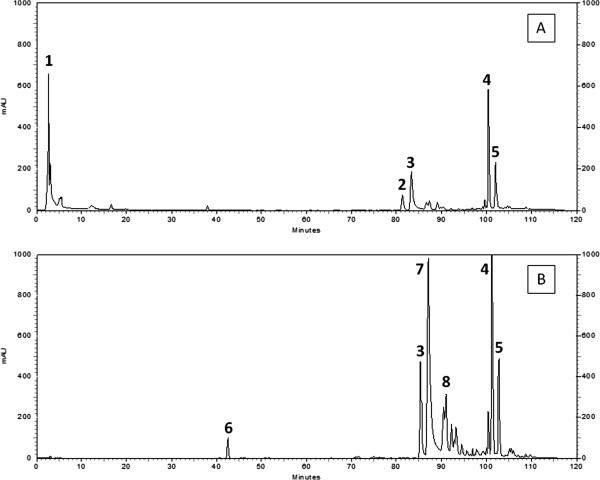
RP-HPLC chromatograms. Chromatogram of the ethanolic extract of geopropolis (EEGP) (A) and its hexane fraction (HF) (B) using photodiode array detector (SPD-M10AVp) at 254 nm; reversed-phase C18 column (250 mm × 4.6 mm i.d.; 5 μm particle size); mobile phase: water/acetic acid (19:1, v/v) (solvent A) and methanol (solvent B) at a constant flow rate of 1 mL/min. The gradient started with 30% solvent B, changing to 40% of B in 15 min, 50% of B in 30 min, 60% of B in 45 min, 75% of B in 65 min, 75% of B in 85 min, 90% of B in 95 min, 90% of B in 110 min, and 30% of B in 120 min. The column was maintained at 35°C. Constituents are represented only by the absorption spectra in the UV (λmax): 1: UV λ 241 nm, RT = 2.72 min; 2: UV λ 287 nm, RT = 81.40 min; 3: UV λ 283 nm, RT = 83.31 min; 4: UV λ 279 nm, RT = 100.53 min; 5: UV λ 281 nm, RT = 101.95 min; 6: UV λ 240 nm, RT = 42.54 min; 7: UV λ 282 nm, RT = 87.14 min; 8: UV λ 284 nm, RT = 91.00 min.